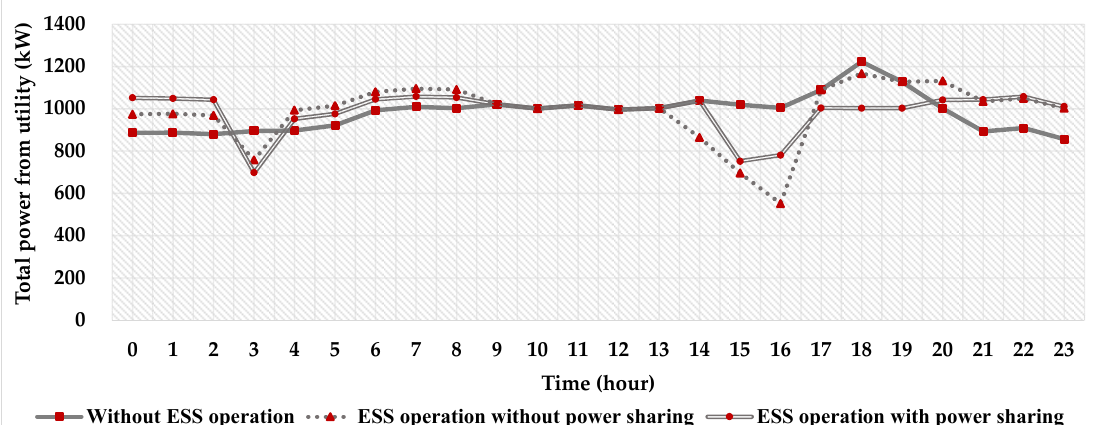
Figure 11. Total electricity supplied by the utility according to the different MG operation schemes.